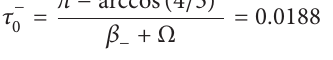
−𝜅 sin Ω̃𝜏 ± 𝑗 𝜅 cos Ω̃𝜏 ± 𝑗